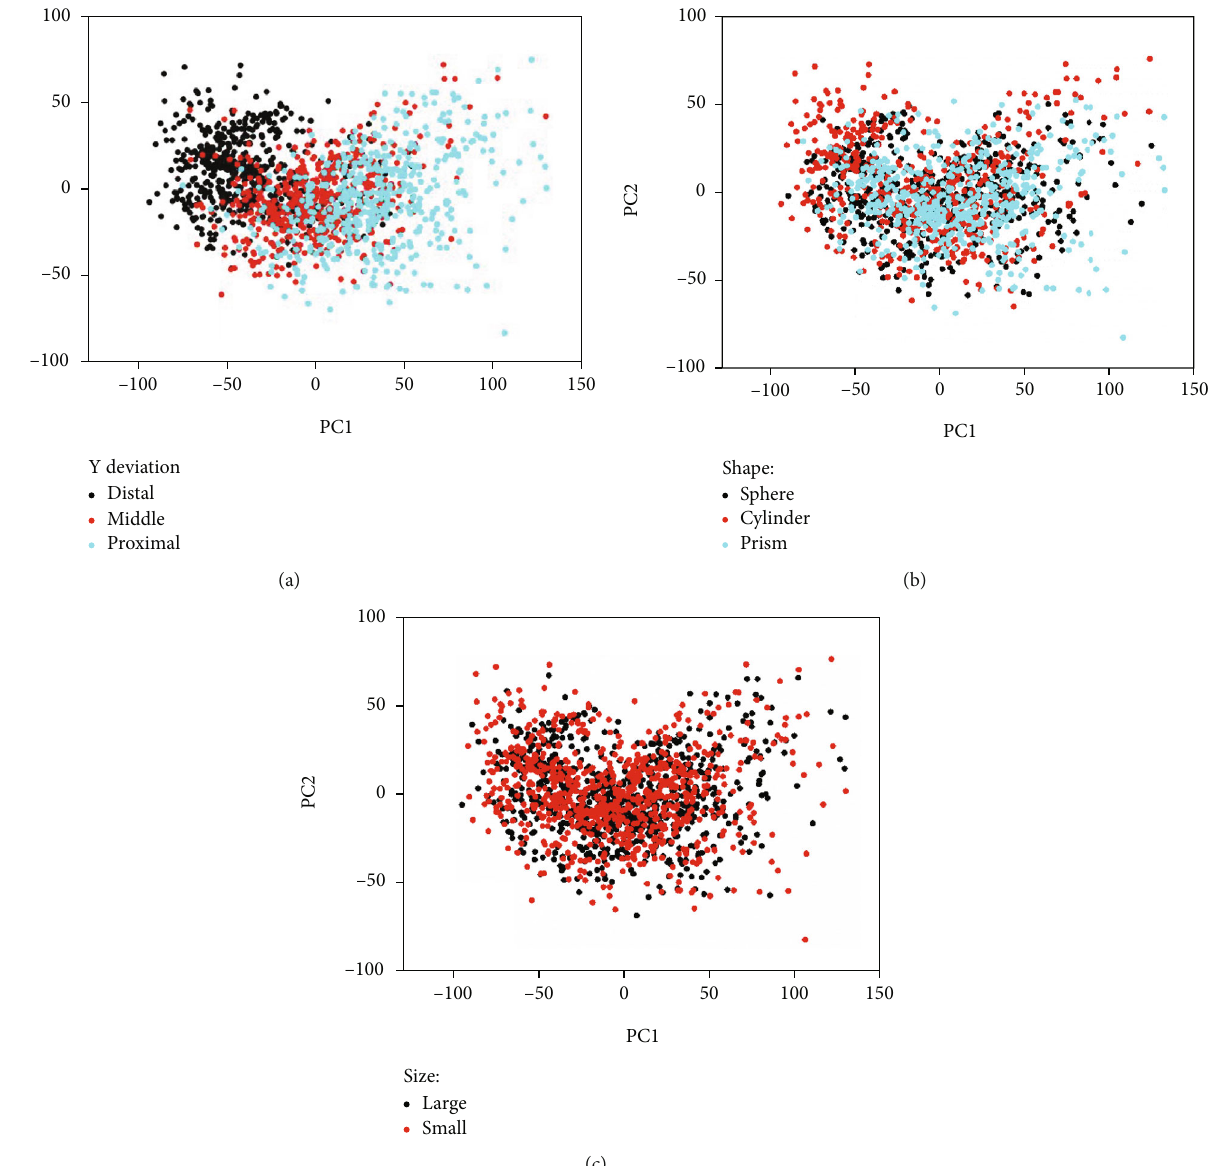
Figure 9: PCA of thumb posture. All 1620 samples across all subjects and experimental conditions are represented in the PC1-PC2 space. Each point represents one particular experimental condition for one subject (average of two repeated trials): (a) Y deviation (black distal in Y direction, red middle in Y direction, green proximal in Y deviation). Clearly, PC1 separates Y deviation; (b) shape (black sphere, red cylinder, green prism); (c) size (black large size, red small